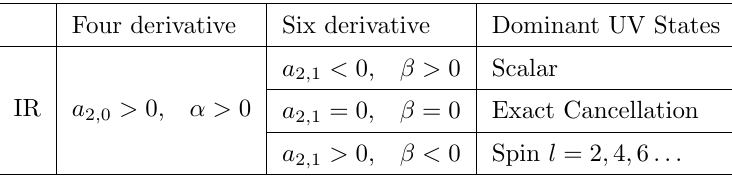
Table 1 . The sign of (cid:11) in the low energy EFT (or equivalently the coe(cid:14)cient a 2 ; 0 of s 2 in the low-energy four-point scattering) is universally positive. On the other hand, the sign of (cid:12) (or equivalently the coe(cid:14)cient a of s 2 t in the low-energy four-point scattering) re(cid:13)ects which UV 2 ; 1 states provide dominant contributions to low-energy scattering. The conclusion summarized in the table applies to any weakly coupled, Lorentz-invariant, analytic and unitary UV completion as well as e(cid:11)ective interactions mediated by KK